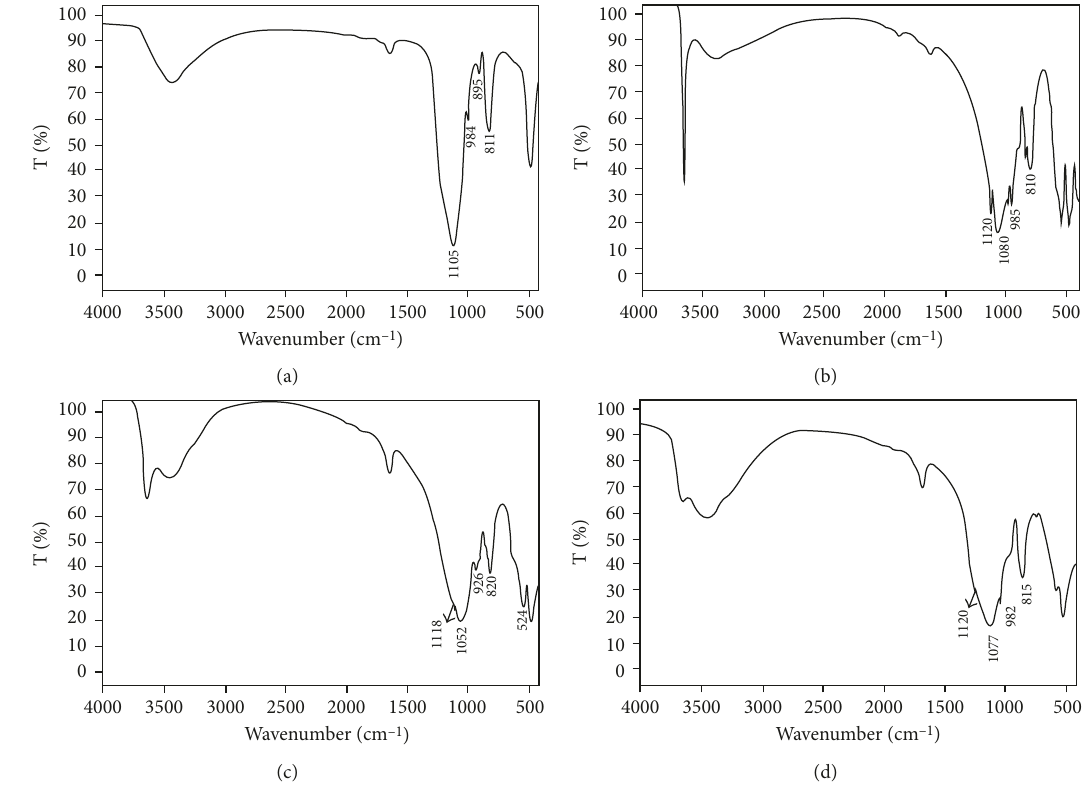
Figure 2: FT-IR spectra of (a) 25% HPW/SiO 2 (HPW-S), (b) 25% HPW/kaolinite (HPW-K), (c) 25% HPW/bentonite (HPW-B), and (d) 25% HPW/montmorillonite (HPW-M). Table 1: The texture of various supported HPW catalysts obtained from nitrogen adsorption.